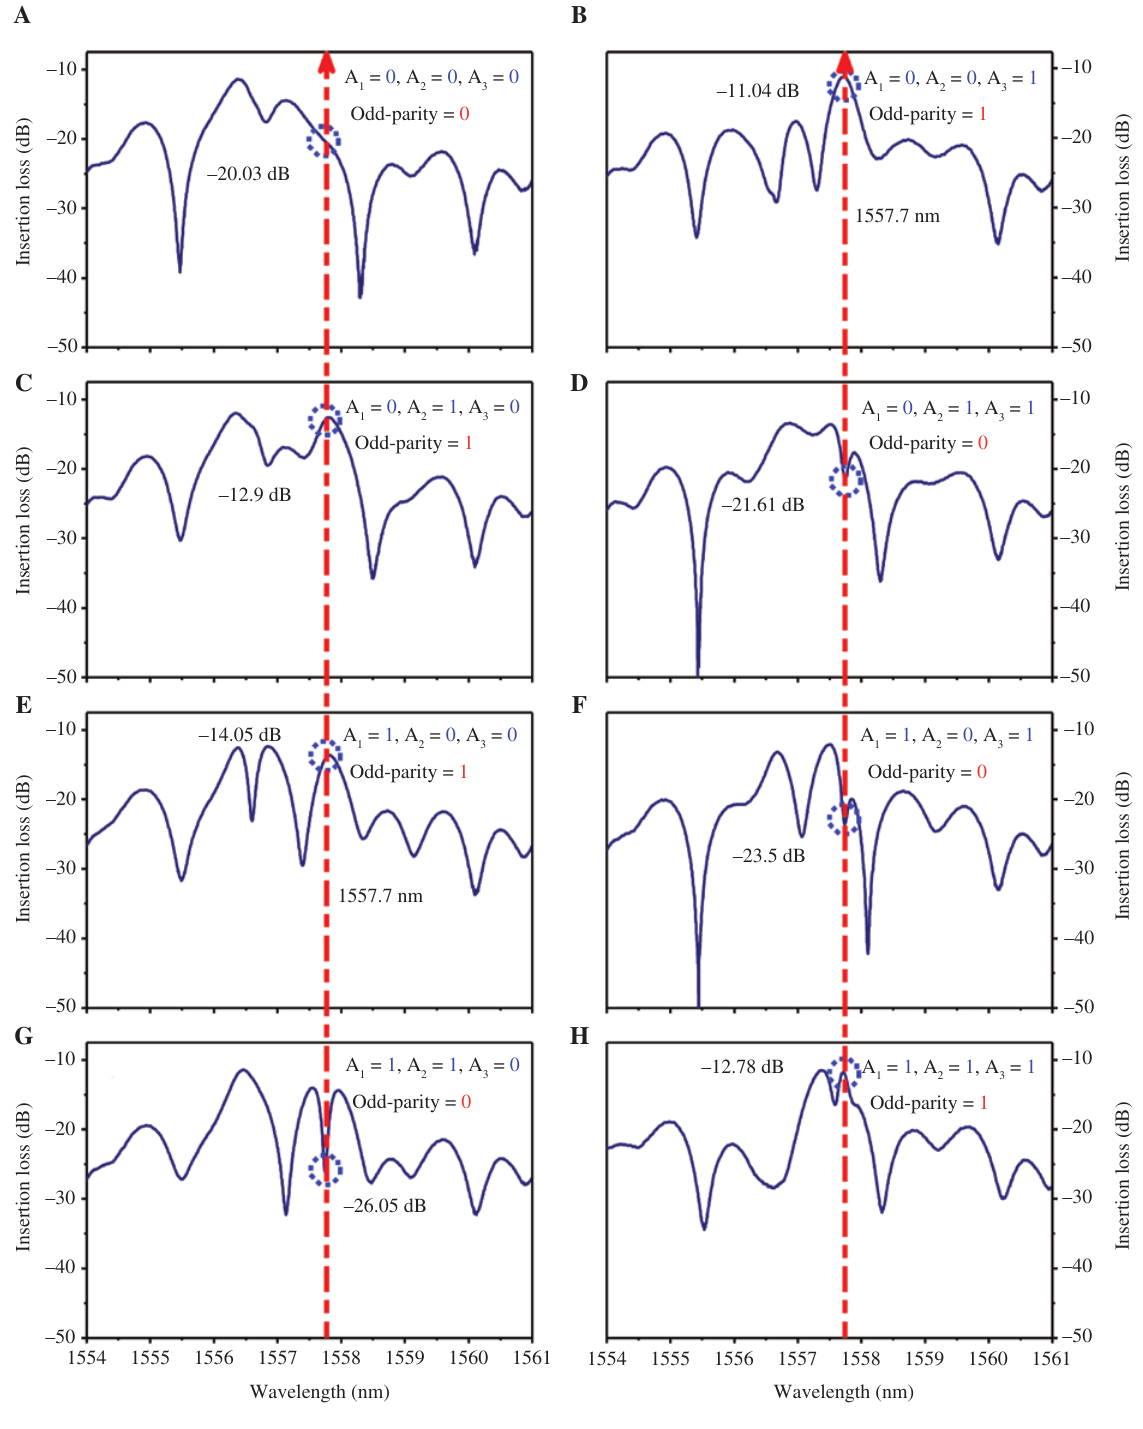
Figure 5: Response spectra in the odd-parity port under different combinations of voltages. In (A)–(H), the logic 1 (0) of each signal represent that the corresponding voltage is at high (low) level. The high levels of voltage applied to , MRR , and MRR are 2.82 V, 2.30 V, and 2.62 V, respectively, while the low levels are all at 0 the micro-heaters above MRR 1 2 3